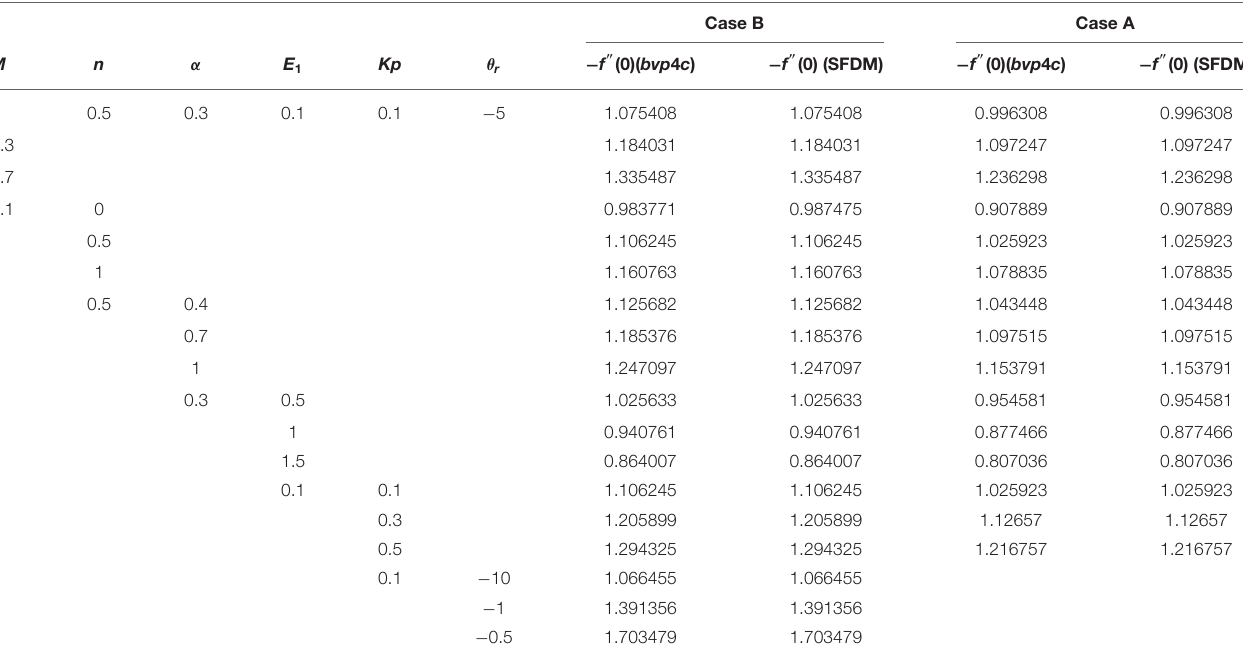
TABLE 2 | Resemblance of the values of − f ′′ (0) for different values of parameters M , n , α , E 1 , and θ r